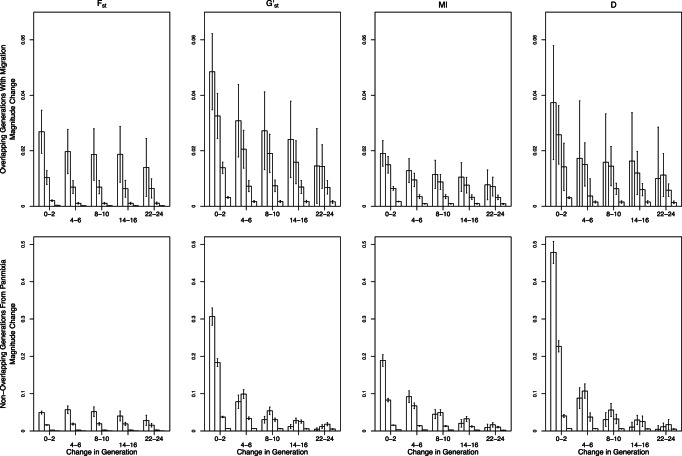
Magnitude of change between consecutive sets of two-generations over the first 24 generations following termination of migration.Bars from left to right are N
max = 25, 75, 500 and 3000 with standard error. Note the scales in the upper panel differ from those in the lower panels.